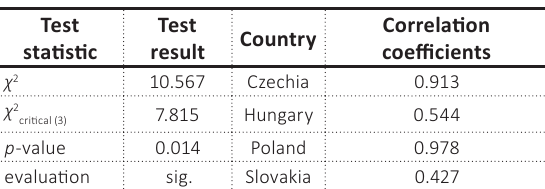
Source: Own processing.